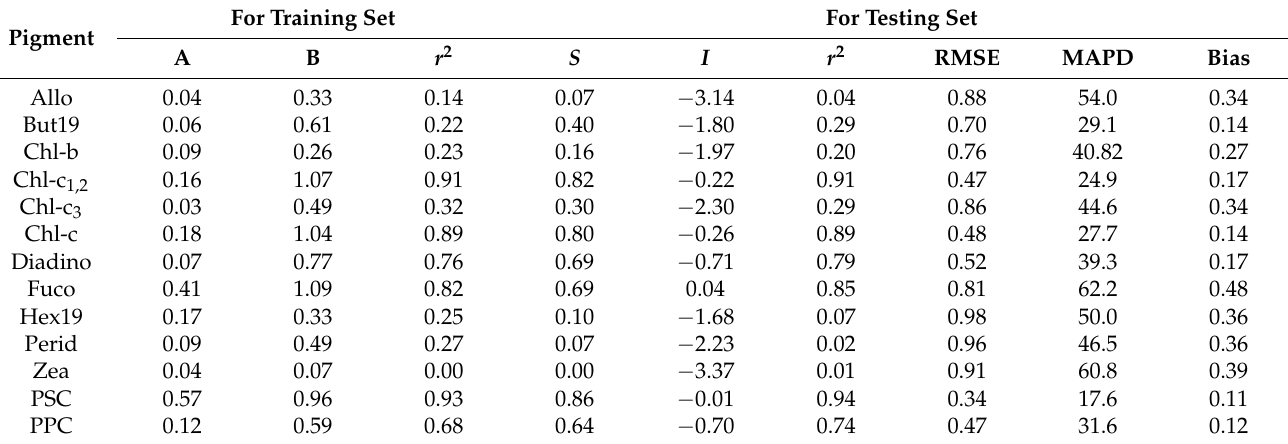
Table 3. Statistics for the Chl-a model including A and B in Equation (1), slope ( S ), intercept ( I ), and determination coefficient (r 2 ) for the linear regression, root mean square error (RMSE, mg m − 3 ), median absolute percent difference (MAPD, %), and bias (Bias, mg m − 3